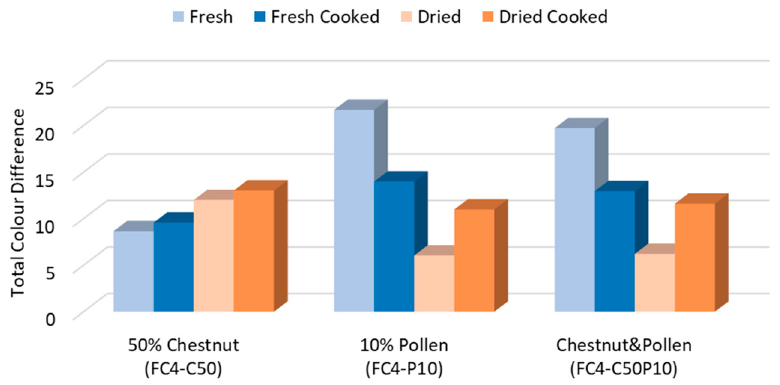
Figure 6. Color difference in relation to control.